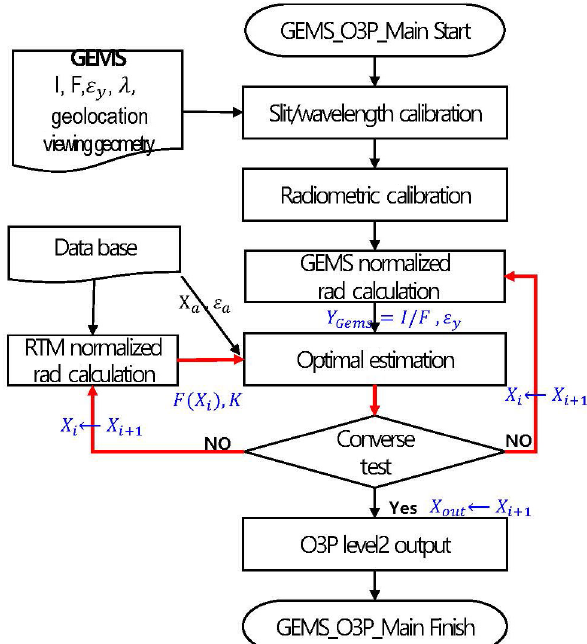
Figure 1. Flow chart of the GEMS ozone profile retrieval